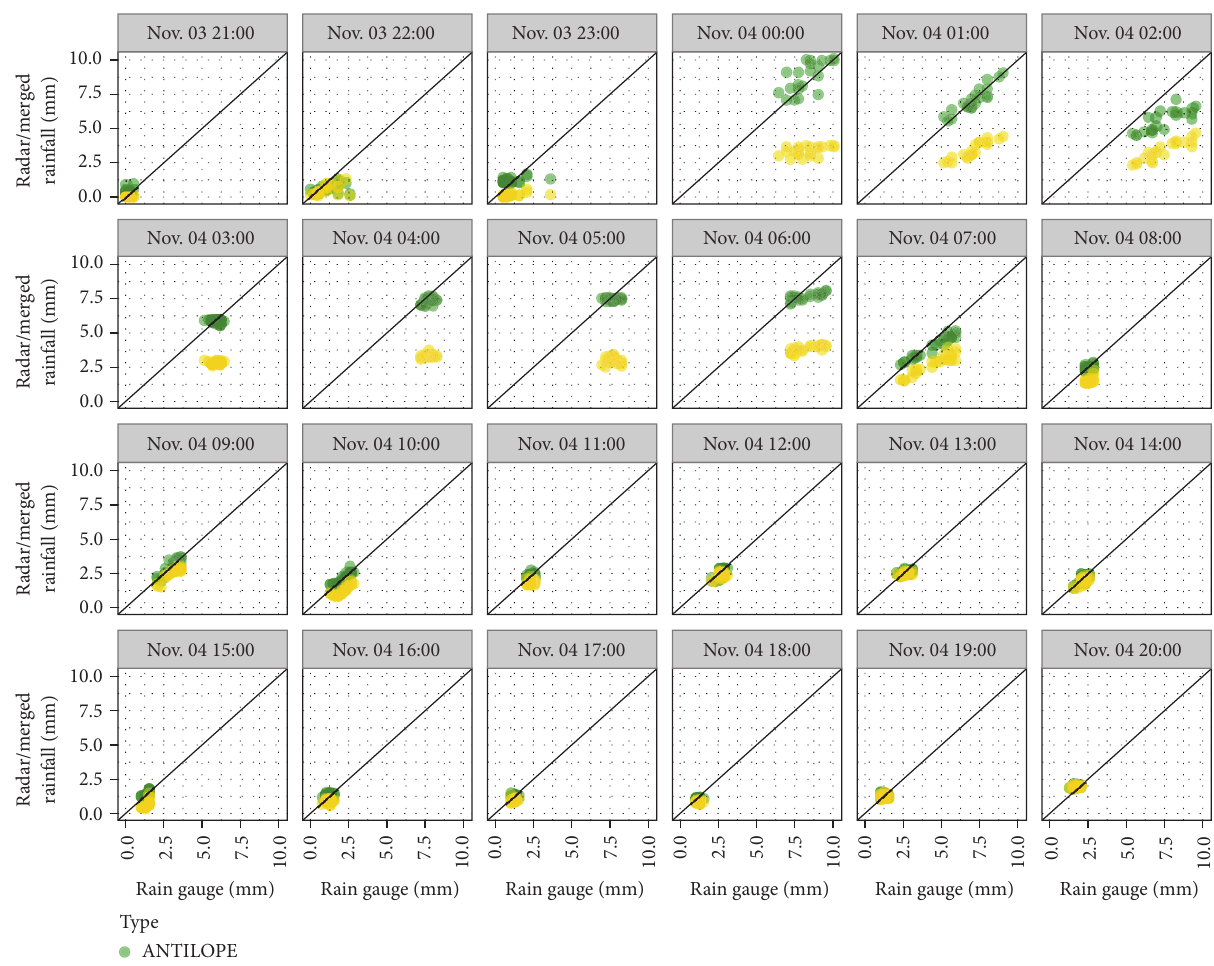
Figure 4: Hourly comparison between grid-pixels for PANTHERE and ANTILOPE radar products and HydraVitis rain gauges.